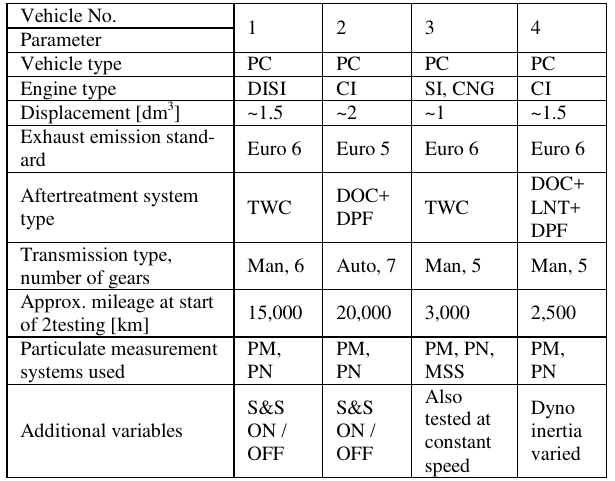
Table 2. Basic data of the test vehicles used in this study Vehicle